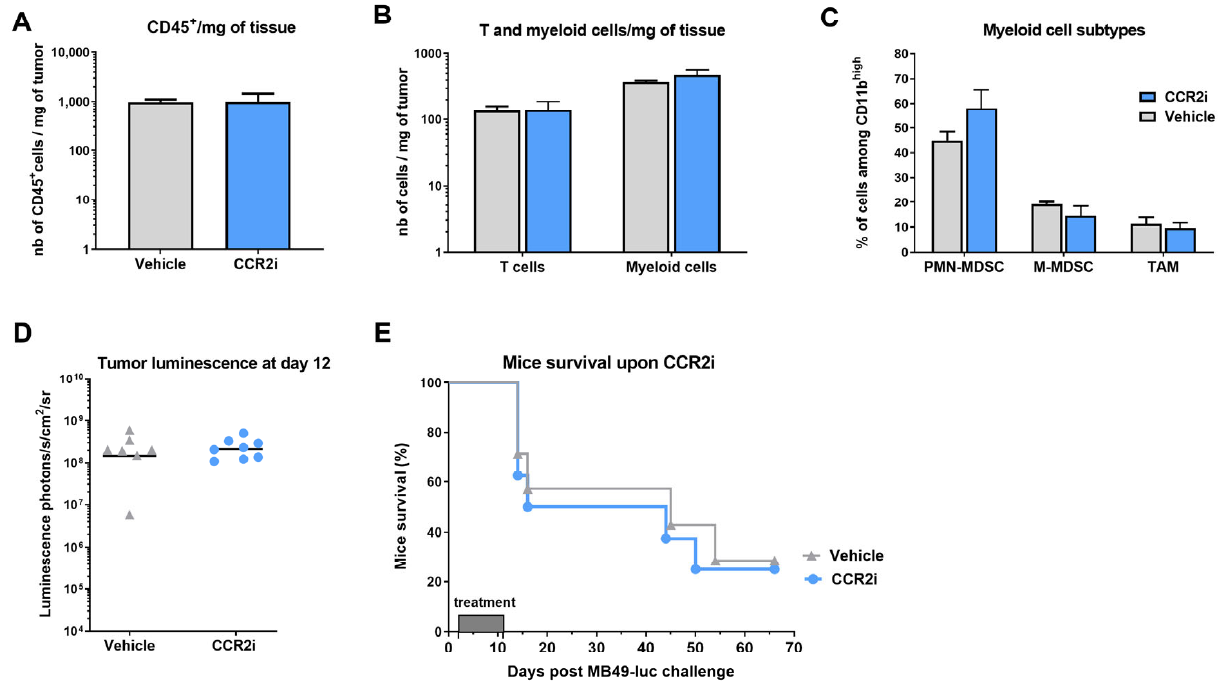
Figure 3. CCR2i treatment of MB49-luc tumor bearing mice. Mice bearing intravesical MB49-luc tumors were subcutaneously injected with 2 mg of a CCR2i twice a day for 10 days, starting 24 h after tumor instillation. A subset of 7 mice (vehicle n = 3, CCR2i n = 4) were sacrificed at day 9 for flow cytometry analysis ( A – C ). Absolute number/ mg of tumors of CD45 + cells ( A ), T cells and myeloid cells ( B ) are shown. The different myeloid subsets were further segregated ( C ) as PMN-MDSC (Cd11b high Ly6G high ), M-MDSC (CD11b high Ly6C high ), TAM (CD11b high Ly6C low Ly6G low F480 + ), and shown among CD11b high cells. Tumor growth is shown by bioluminescence at day 12 in ( D ) and mice survival in ( E ) (vehicle n = 7, CCR2i n = 8). No significant differences were observed following a t -test ( A – D ) or an adjusted log rank test ( E